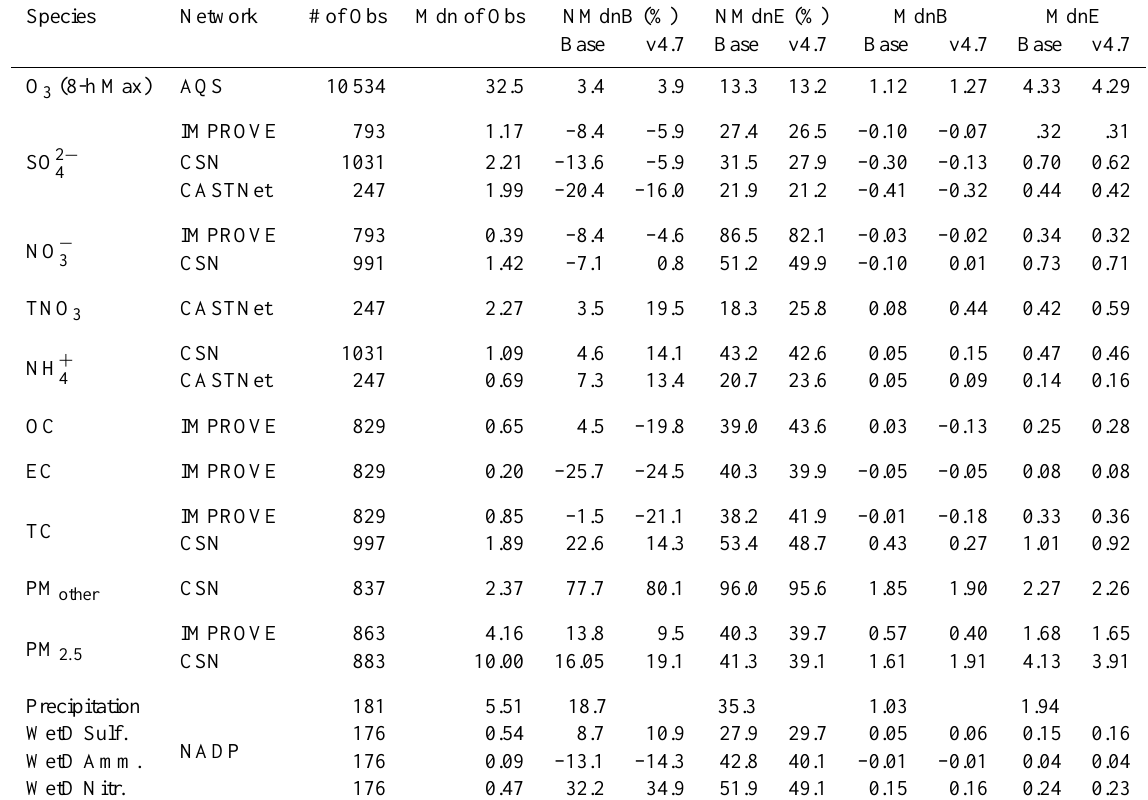
Table 3. RMSE, NMdnB, NMdnE, MdnB and MdnE for O 3 (ppb), fine-particulate mass and species (µg/m 3 ), precipitation (cm) and wet deposition species (kg/ha) for January 2006. These metrics are defined in Table